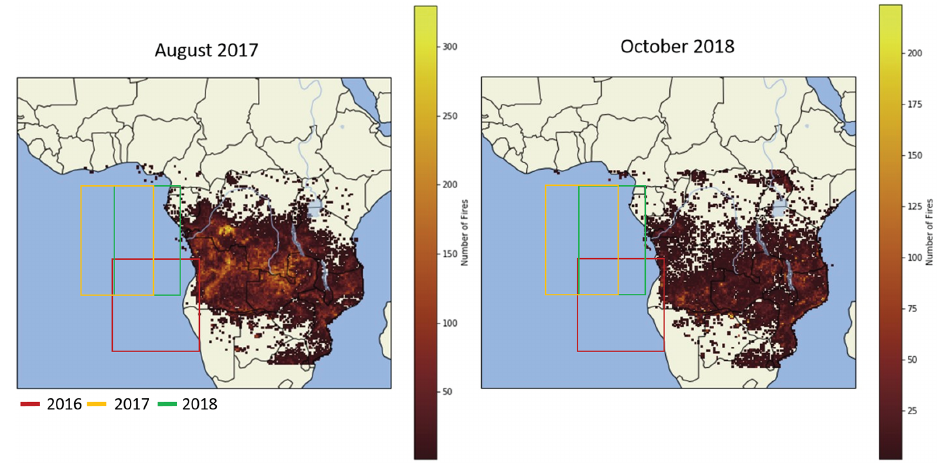
Figure 6. FIRMS MODIS 6 active fire map data for the months of August 2017 and October 2018, showing extensive biomass burning in central Africa. The boxes show the 2016 flight area (red), the 2017 flight area (yellow), and the 2018 flight area (green).